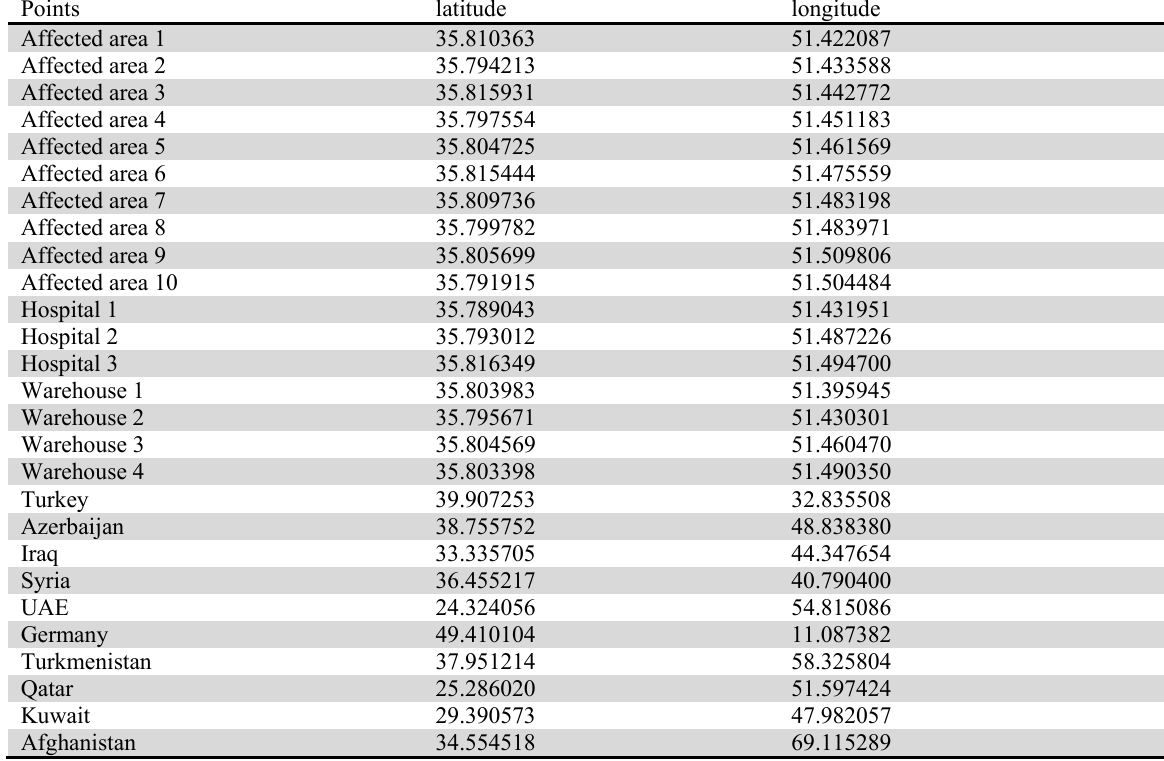
The latitude and longitude of the affeced areas, located hospitals and located warehouses and foreign suppliers